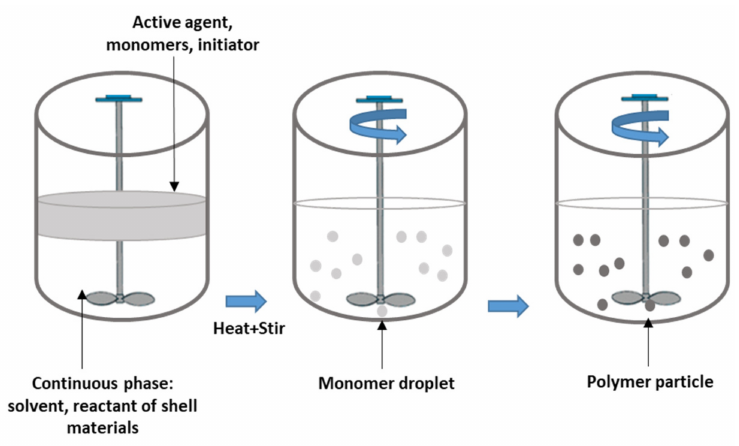
Figure 4. Schematic representation of the microencapsulation by suspension